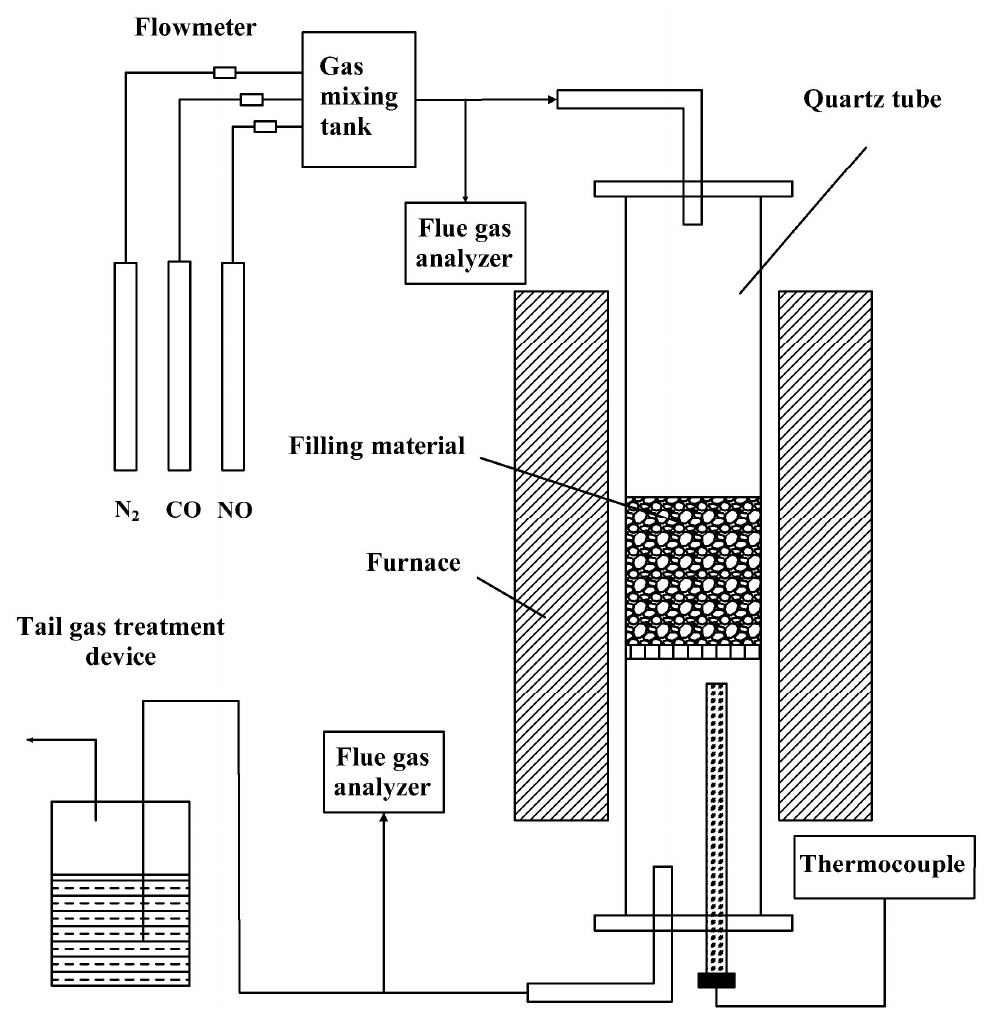
Figure 2. Schematic diagram of catalytic reduction experiment apparatus.